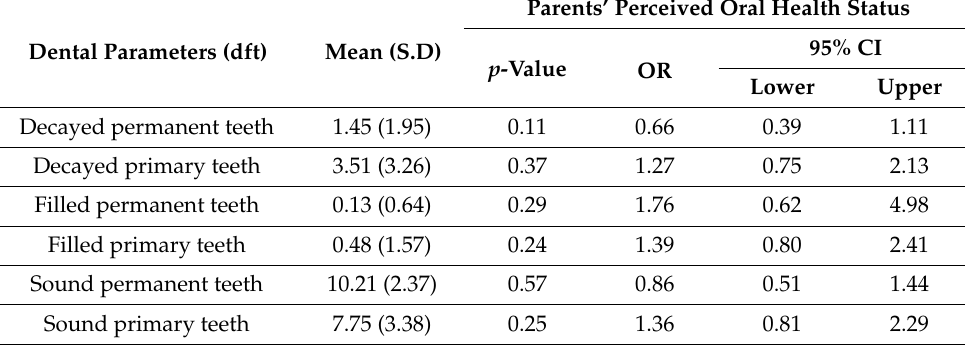
Table 3. Relationship between clinical dental parameters and parents’ perceived oral health status of children.